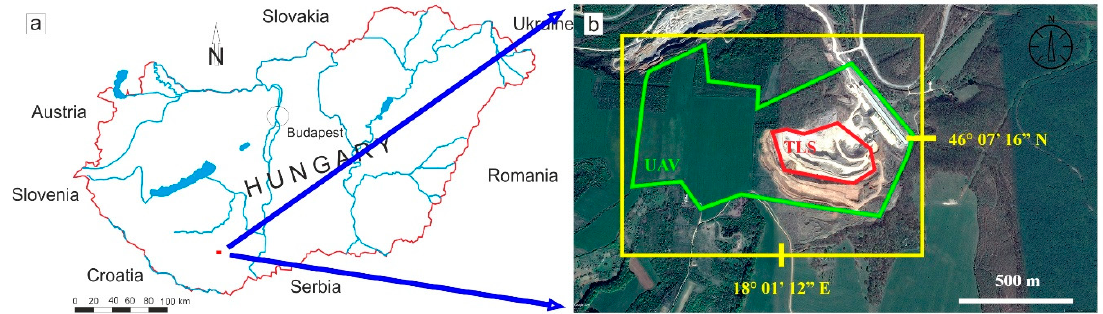
Figure 1. Location of the study site: ( a ) Hungary with the study site ( b ) close view of the study area with WGS 84 coordinates and unmanned aerial vehicle UAV (green boundary line) and TLS (red boundary line) surveyed areas (Google Earth).